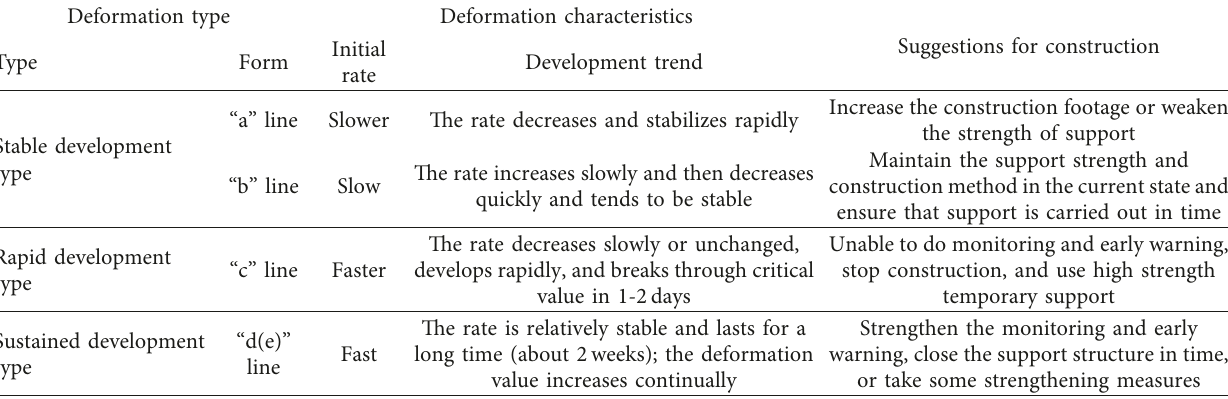
Table 1: Characteristics of deformation evolution of the Qinggangshan tunnel exit section and suggestions for construction. Deformation